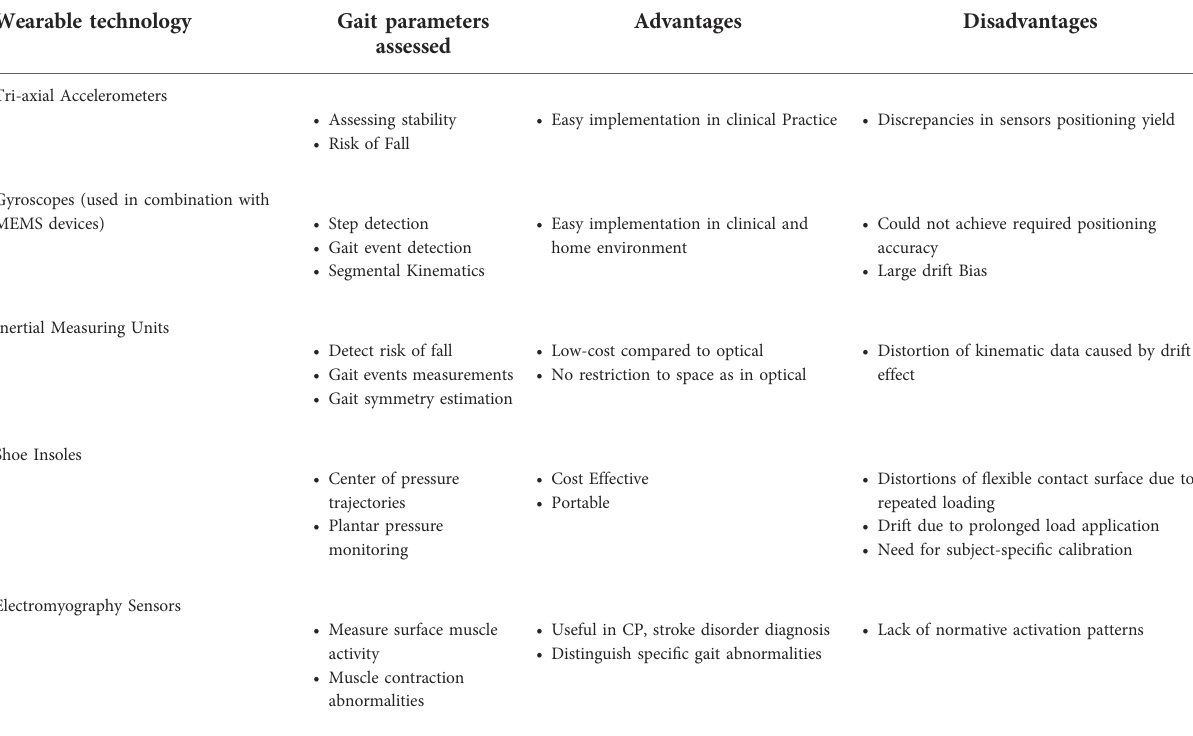
TABLE 4 Portable wearable gait assessment tools. Wearable technology Gait parameters